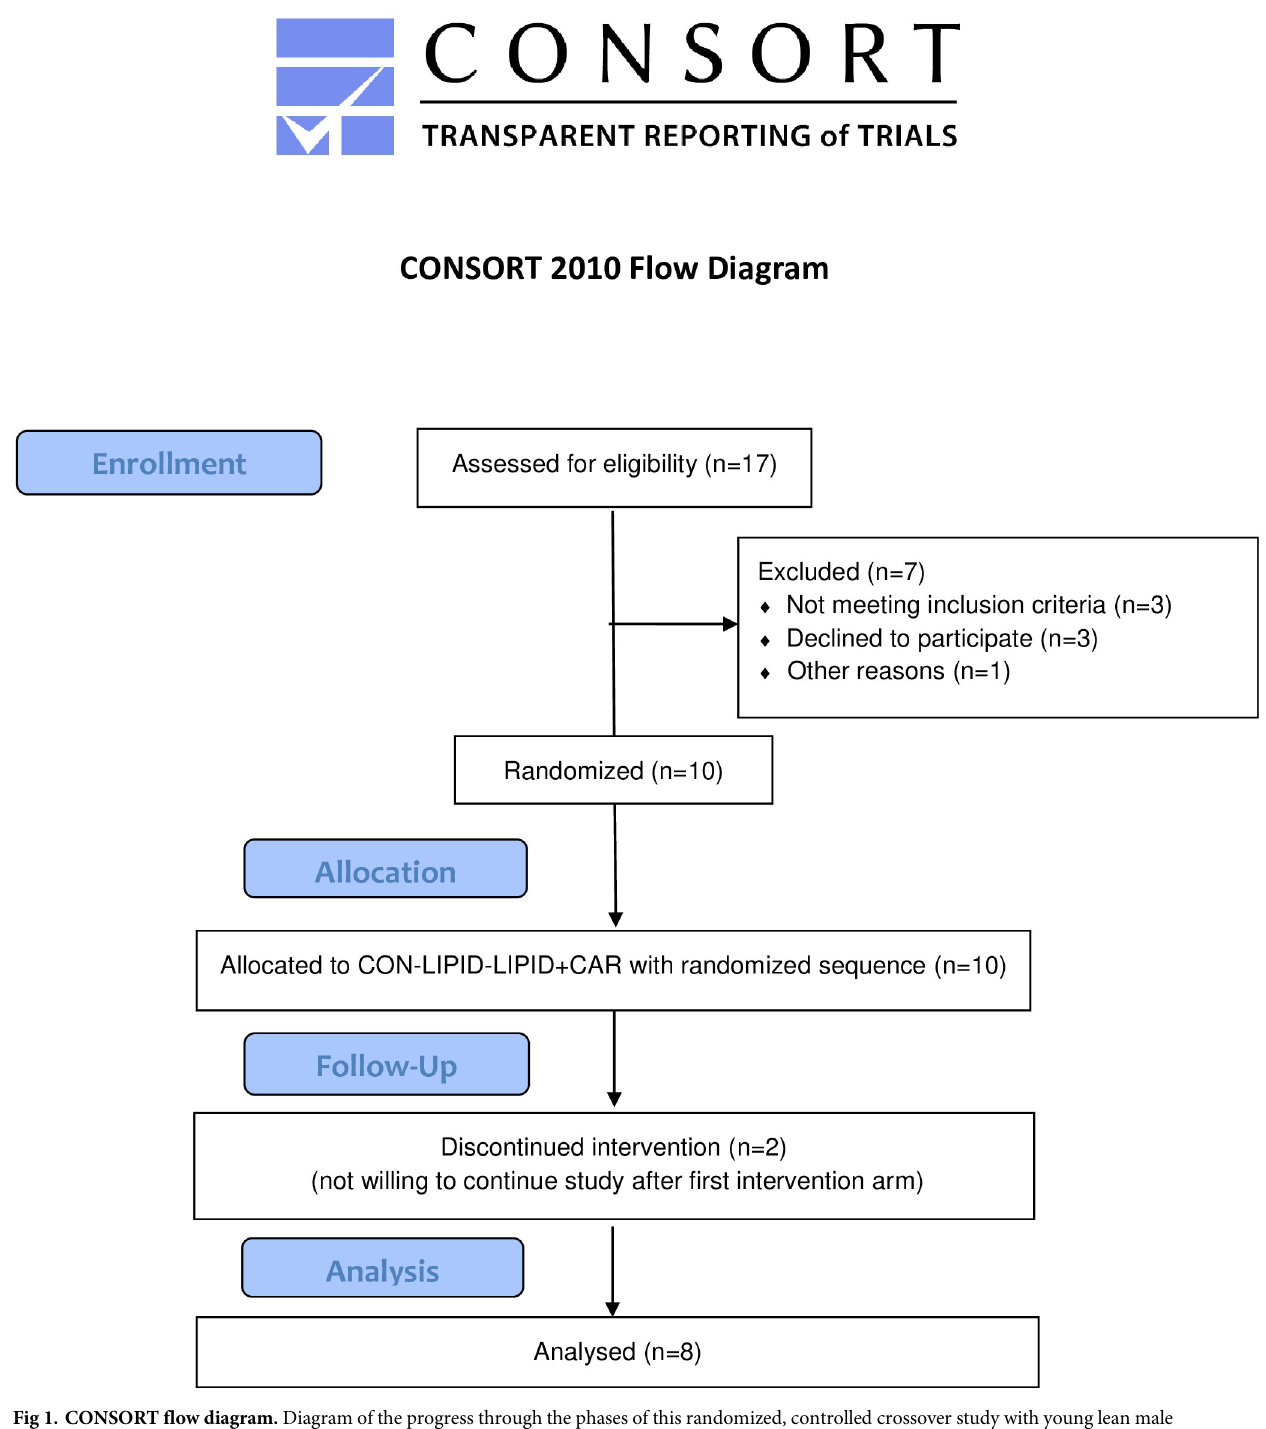
Fig 1. CONSORT flow diagram. Diagram of the progress through the phases of this randomized, controlled crossover study with young lean male participants.